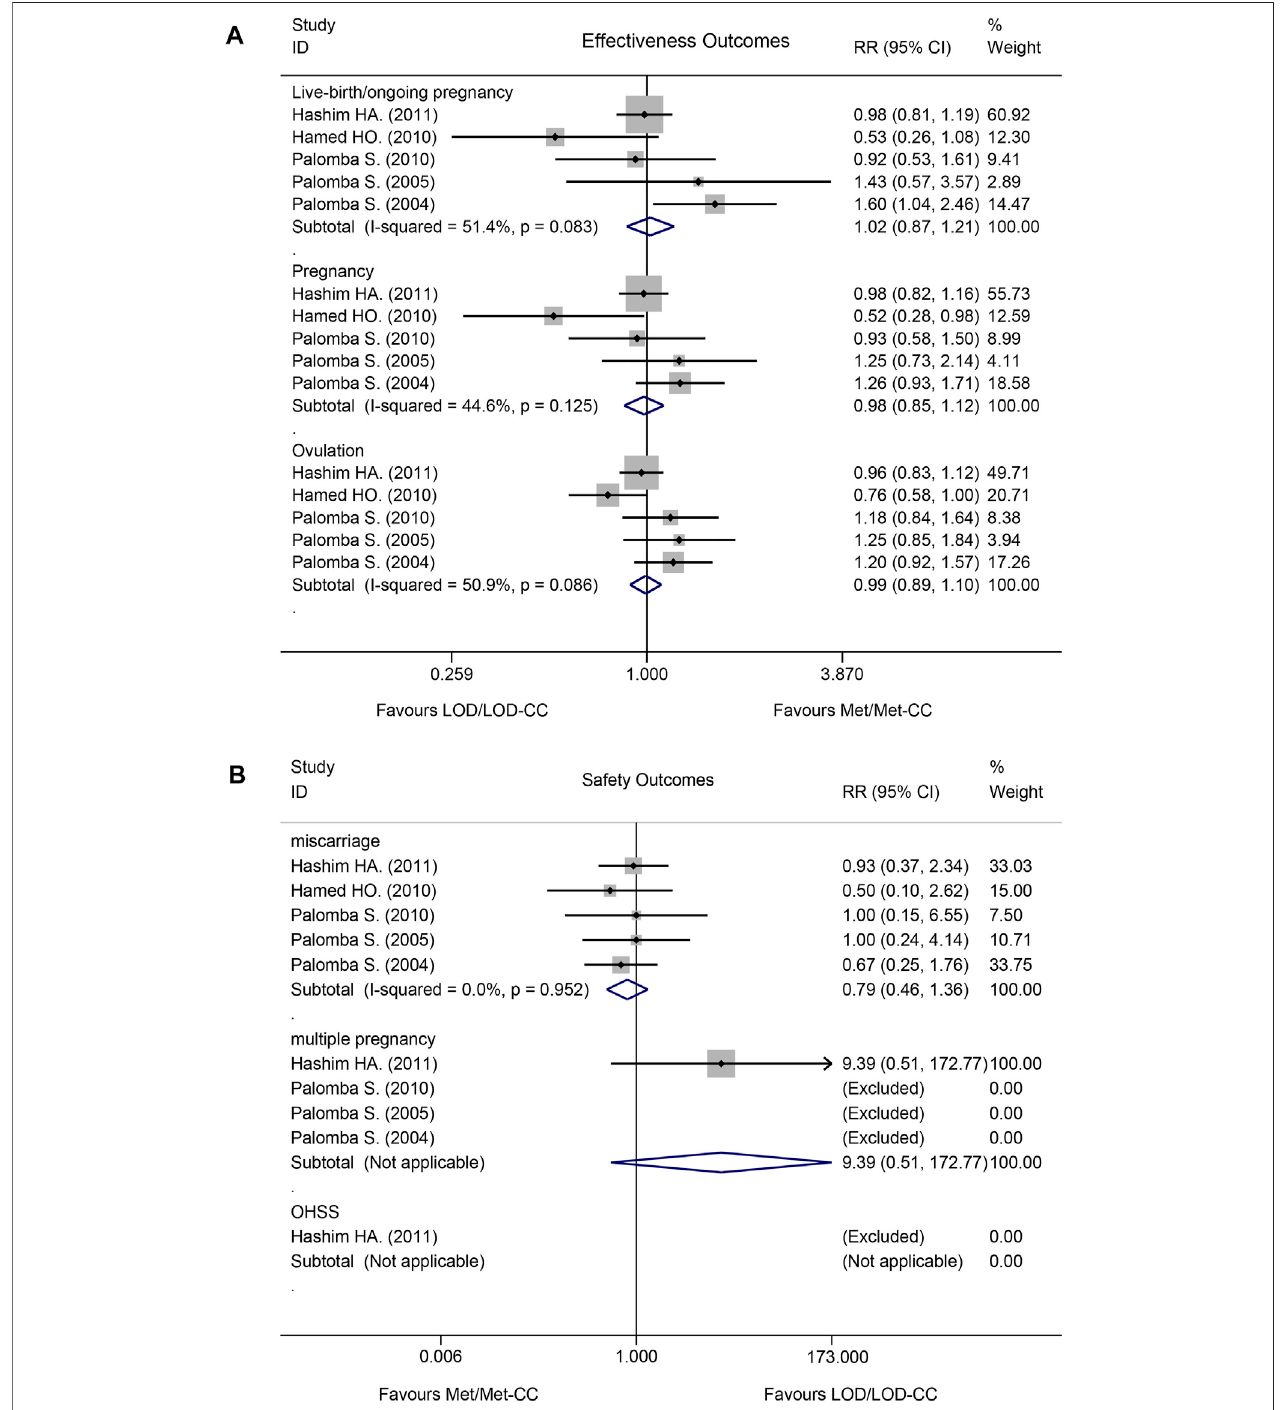
FIGURE 3 | Forest plot of effectiveness and safety outcomes in the Met/Met-CC vs LOD/LOD-CC comparison using the fi xed-effect model: (A) effectiveness; and (B) safety. Notes: Met, metformin, CC, clomiphene citrate, LOD, laparoscopic ovarian drilling.